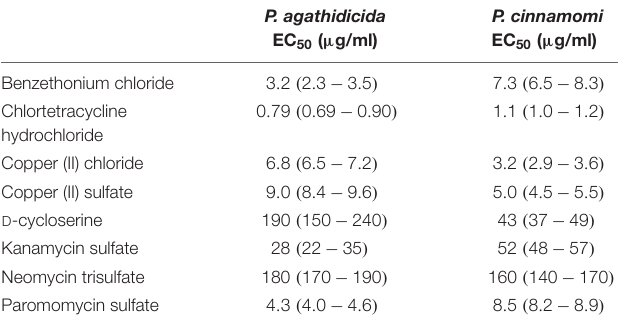
TABLE 1 | EC 50 values for inhibition of mycelial